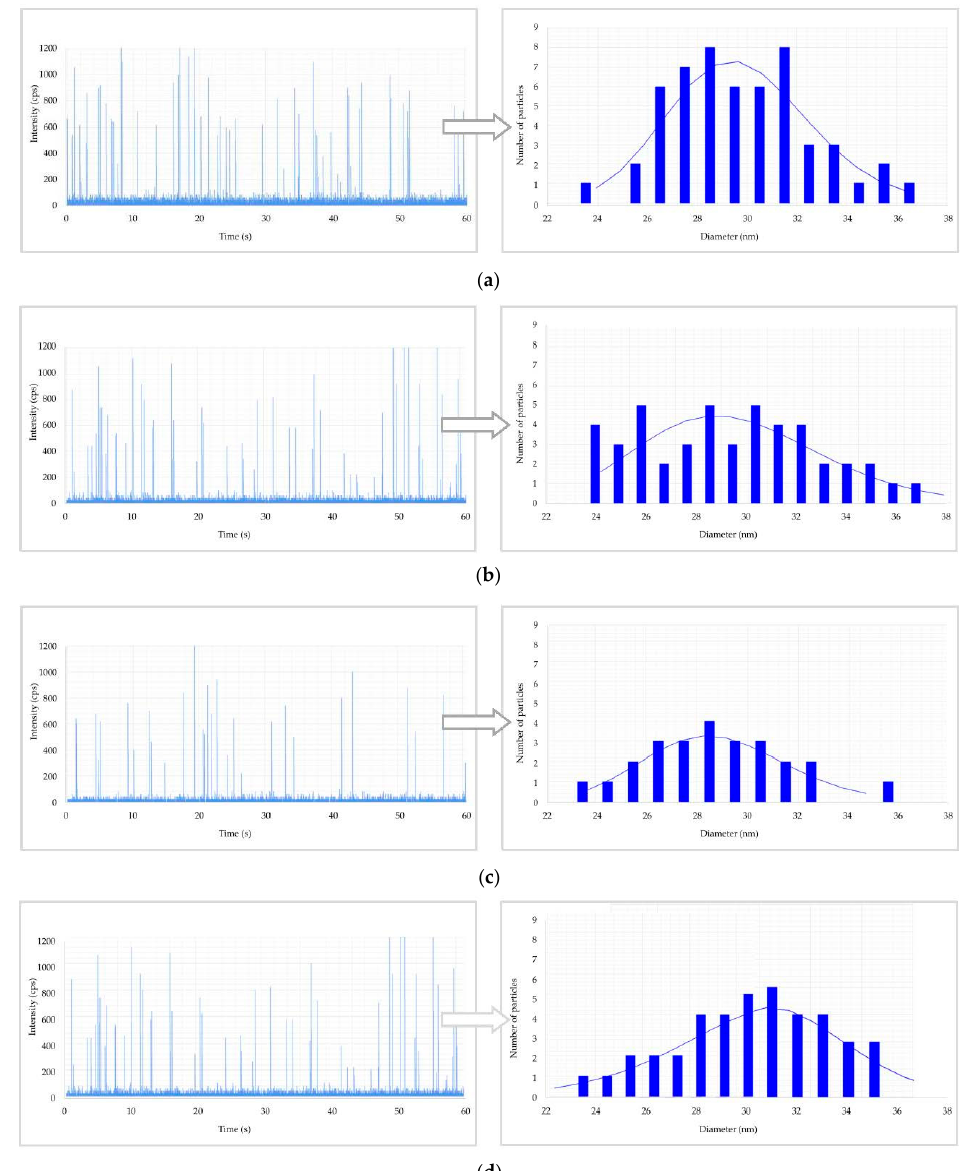
Figure 2. Results of Ag nanoparticles (NPs) found in urine of a worker: ( a ) raw data and particle size distribution (PSD) at pre-shift start of week; ( b ) raw data and PSD at post-shift start of week; ( c ) raw data and PSD at post shift end of week; ( d ) raw data and PSD in a control worker. Table 4. Analysis of metal nanoparticles (NPs) in blood of workers from Company A (no. 1–3), Company B (no. 4–6) and controls (No. 7–8), at the end of working week (4th day).